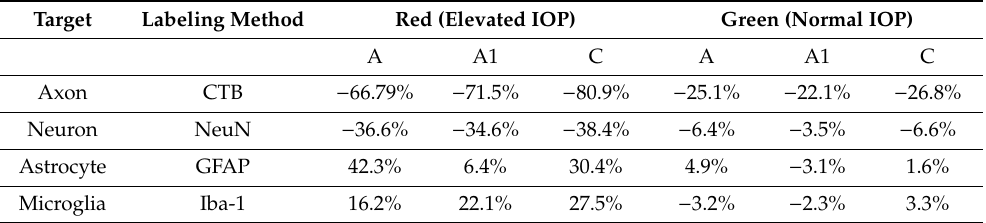
Table 1. Quantitative analysis of projecting axons and neuroglial responses in A, A1, and C layers of OH ferret